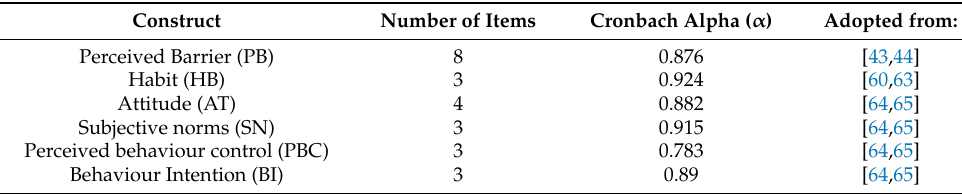
Table 1. Construct items and reliability analysis of the